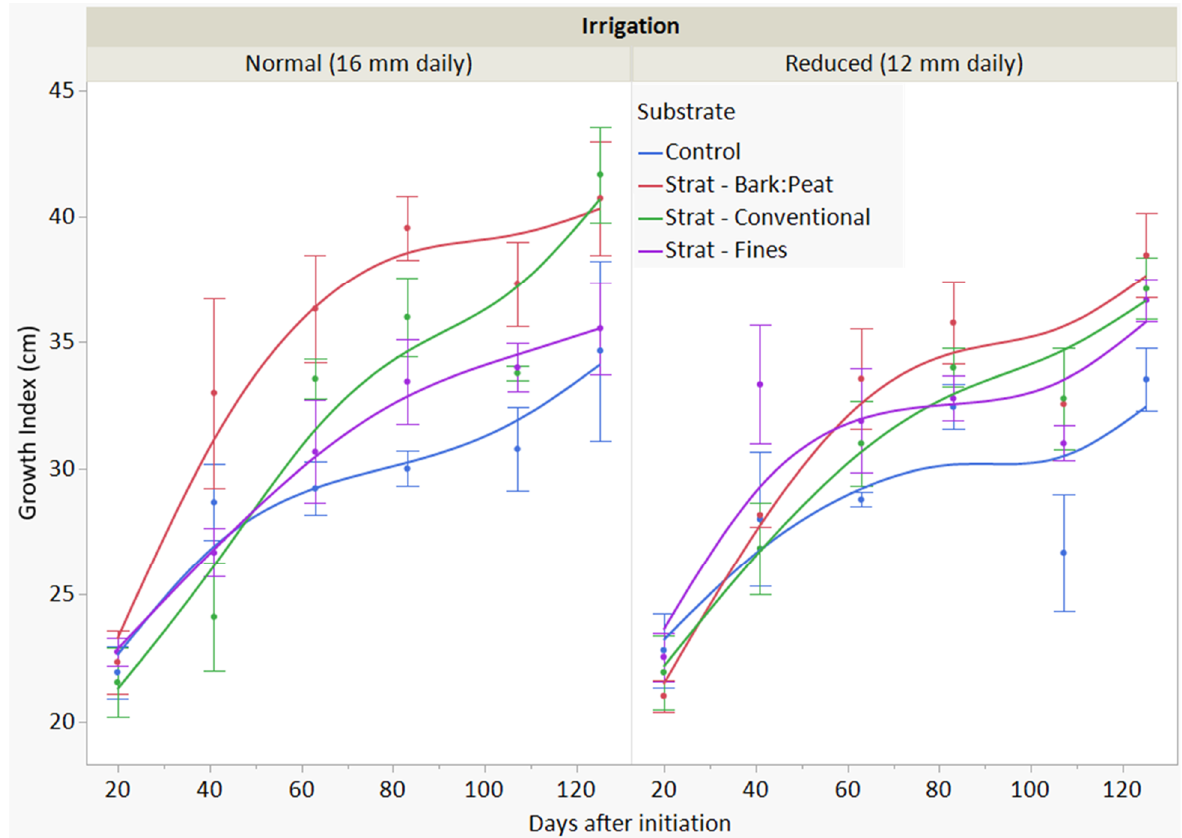
Figure 2. The changes in growth index for Drift roses planted in a conventional pine bark substrate (control) or stratified substrates, in which either conventional pine bark substrate amended with 35% peat (by vol.; bark–peat), conventional pine bark (conventional), or fine pine bark (fines) was layered on top of coarse screened pine bark. Plants were irrigated with 16 mm (normal; control) or 12 mm of water daily (reduced). Measures reported from 0 to 125 days after initiation. Bars represent standard errors from the mean.